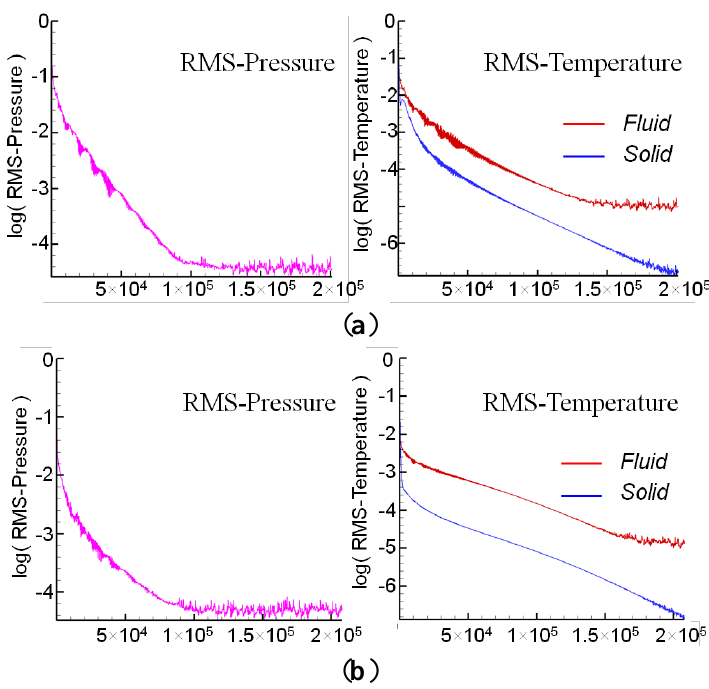
Figure 2. The convergence curves of L 2 -norm of residuals (RMS) in the heat convection cases.